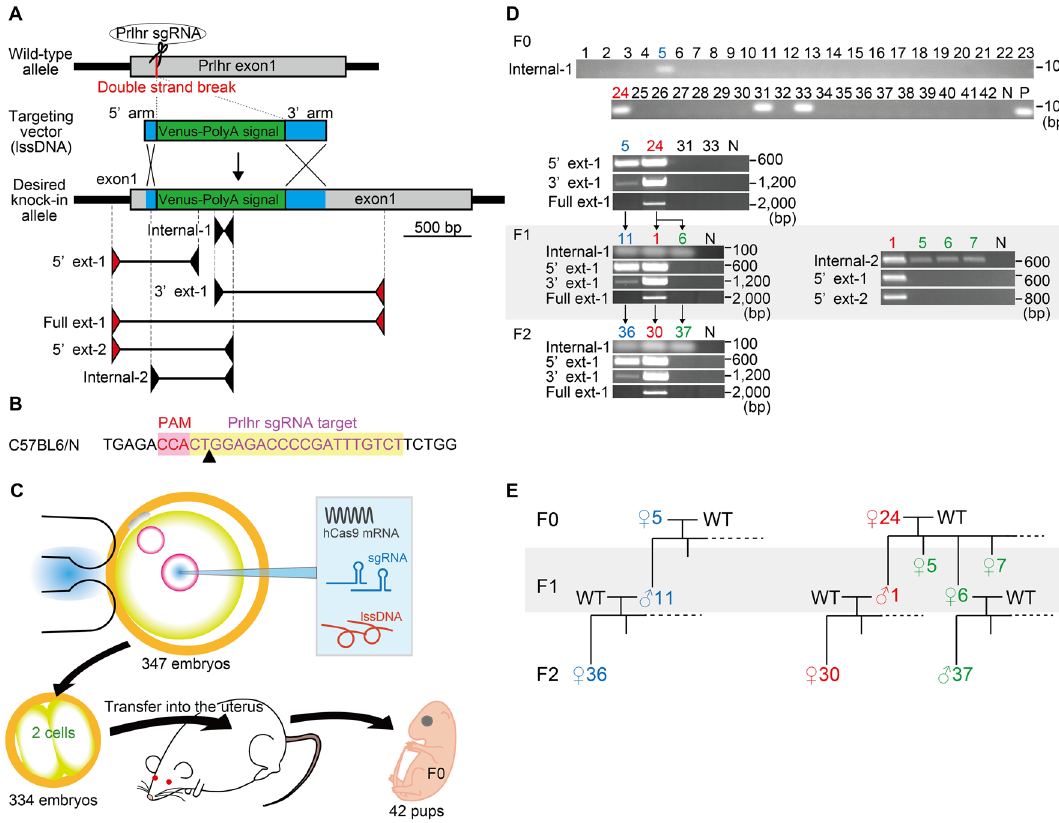
Figure 1. CRISPR-Cas9-mediated knock-in strategy at the prolactin releasing-peptide receptor (Prlhr) locus and analysis of Venus integration using conventional PCR. ( A ) Schematic representation of the wild-type mouse Prlhr genomic locus, sgRNA targeting site, targeting vector containing the Venus-polyadenylation signal, and primer sets (internal primer pair, Internal-1 and Internal-2; primer external to the targeting vector and internal primer pairs, 5’ext-1, 3’ext-1, 5’ext-2; primer pair external to the targeting vector, Full ext-1). Red and black arrows show the primer external to the targeting vector and internal primer, respectively. ( B ) Target sequence of Prlhr sgRNA on the C57BL6/N genome. ( C ) Schematic representation of hCas9 mRNA, sgRNA, and lssDNA co-injection into mouse embryos to generate founders (F0) with the knock-in mutation. ( D ) Conventional PCR analysis of genomic DNA from the F0, F1 and F2 generations using each primer pair. Oxytocin receptor-Venus knock-in heterozygous and wild-type mice were used for positive (P) and negative (N) controls, respectively. Black arrows show the parent–offspring relationships. Uncropped gel images are presented in Supplemental Fig. 9A. ( E ) Family trees of numbers 5 and 24 of the F0 parents (fourth panel of Fig. 1D). Two candidate F0 mice with a Venus insertion in the Prlhr locus were detected by conventional PCR. However, analysis of their F1 and F2 generation progeny showed that F0 number 24 was